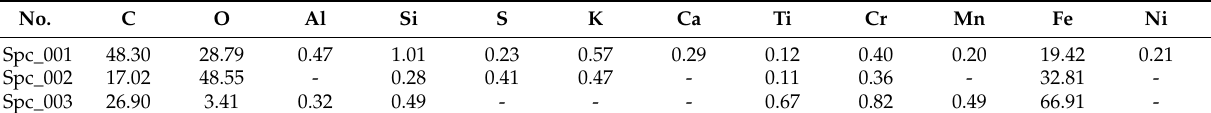
Figure 16. The energy spectrum analysis of worn surface of ZM4-13 under coal gangue percentage of 50% and pH values of simulated mine water of 3.5: worn and corrosive zone 1 ( a ), worn and corrosive zone 2 ( b ), corrosive zone ( c ). Table 3. Element composition of spectrum (at. %).